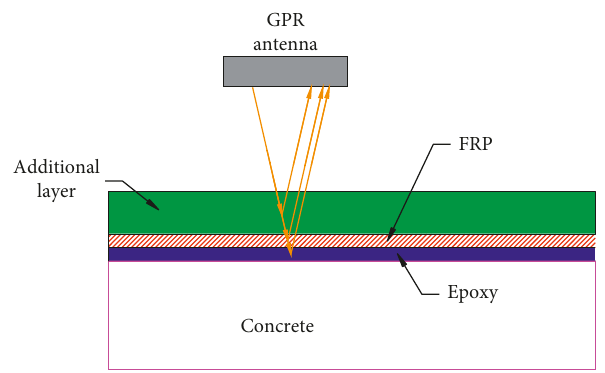
Figure 8: GPR scanning setup.